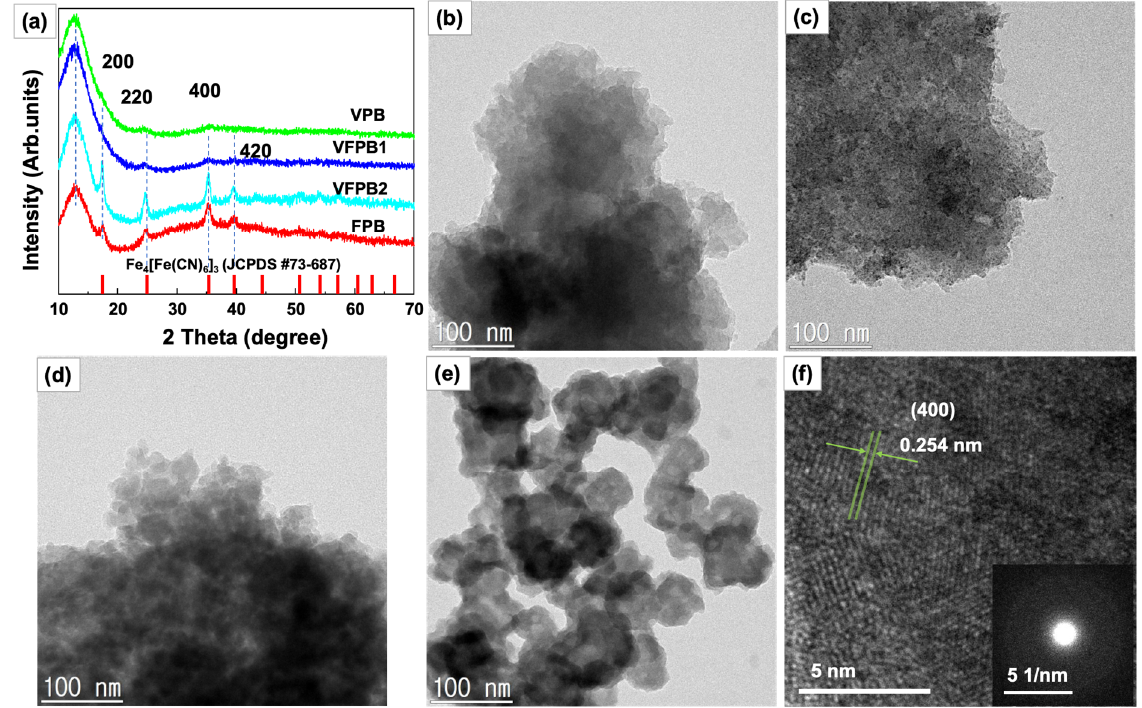
Figure 1. ( a ) X-ray diffraction patterns of VPB, VFPB1, VFPB2, and FPB samples; transmission electron microscope images of ( b ) VPB, ( c ) VFPB1, ( d ) VFPB2, and ( e ) FPB; ( f ) high-resolution image of VFPB1 samples; inset: selected area electron diffraction pattern.